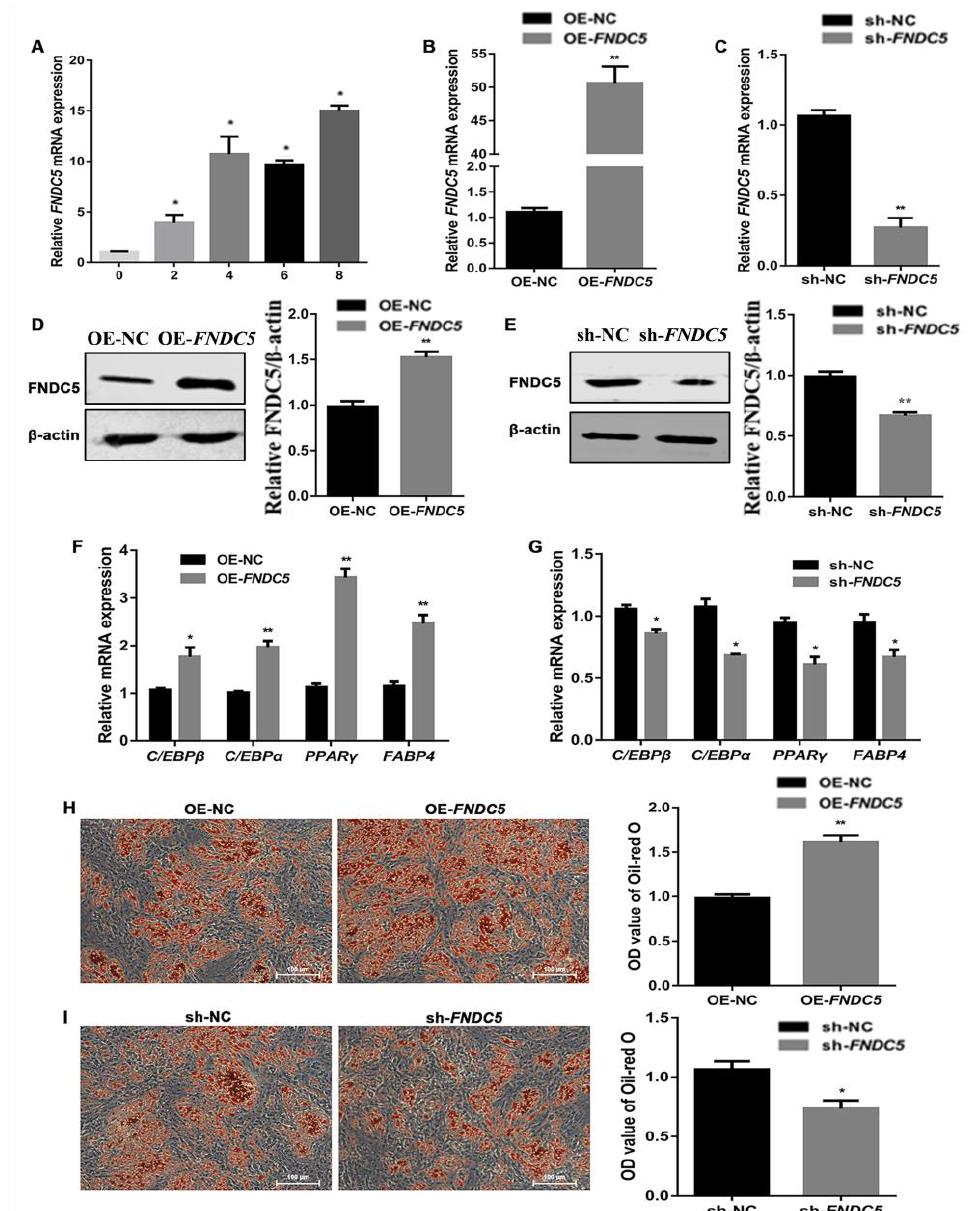
Figure 3. Regulation of FNDC5 in adipogenic differentiation in porcine preadipocytes. ( A ) The expression of FNDC5 at 0, 2, 4, 6 and 8 days during adipogenic differentiation in porcine preadipocytes. ( B , C ) The expression of FNDC5 after transfecting the FNDC5 overexpression and interference vectors. ( D , E ) Western blotting results of FNDC5 after transfecting the FNDC5 overexpression and interference vectors. ( F , G ) The expression of adipogenic marker genes after transfecting the FNDC5 overexpression and interference vectors. ( H , I ) The Oil Red O staining and OD value reflecting the content of triglyceride after transfecting the FNDC5 overexpression and interference vectors. OE-NC and sh-NC mean transfecting the negative control overexpression and interference vectors, respectively. OE- FNDC5 and sh- FNDC5 mean transfecting the FNDC5 overexpression and interference vectors, respectively. The same as below. Scale bars: 100 µ m. Notes: “**” means extremely significant difference ( p < 0.01) and “*” means significant difference ( p < 0.05).